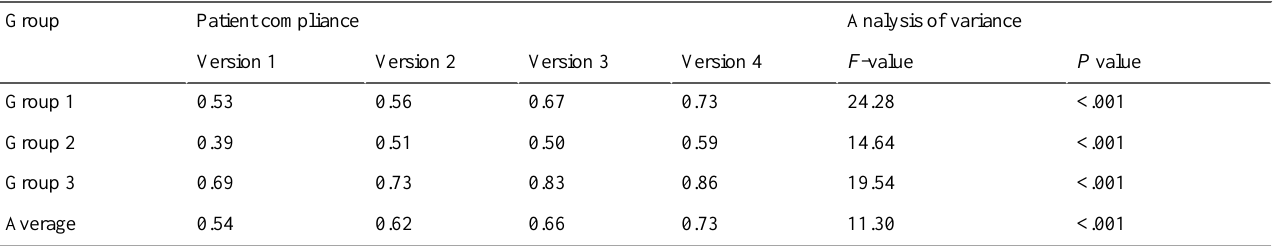
Table 7. Patient compliance among the different